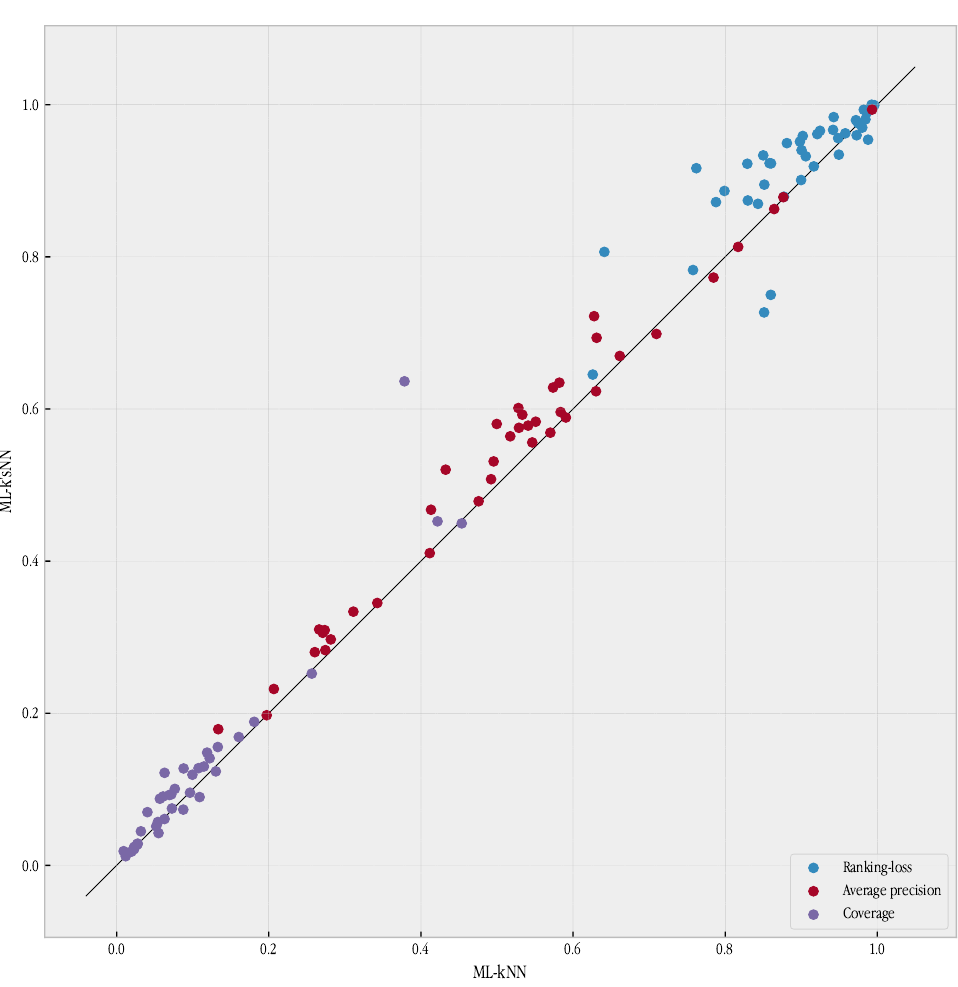
Figure 3. Results for ML-kNN and ML-k’sNN for the three metrics: average precision, coverage, and